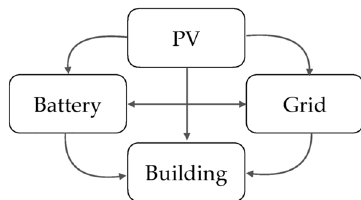
Fig. 3 Schematic of the sub-systems and their interactions used in the MPC